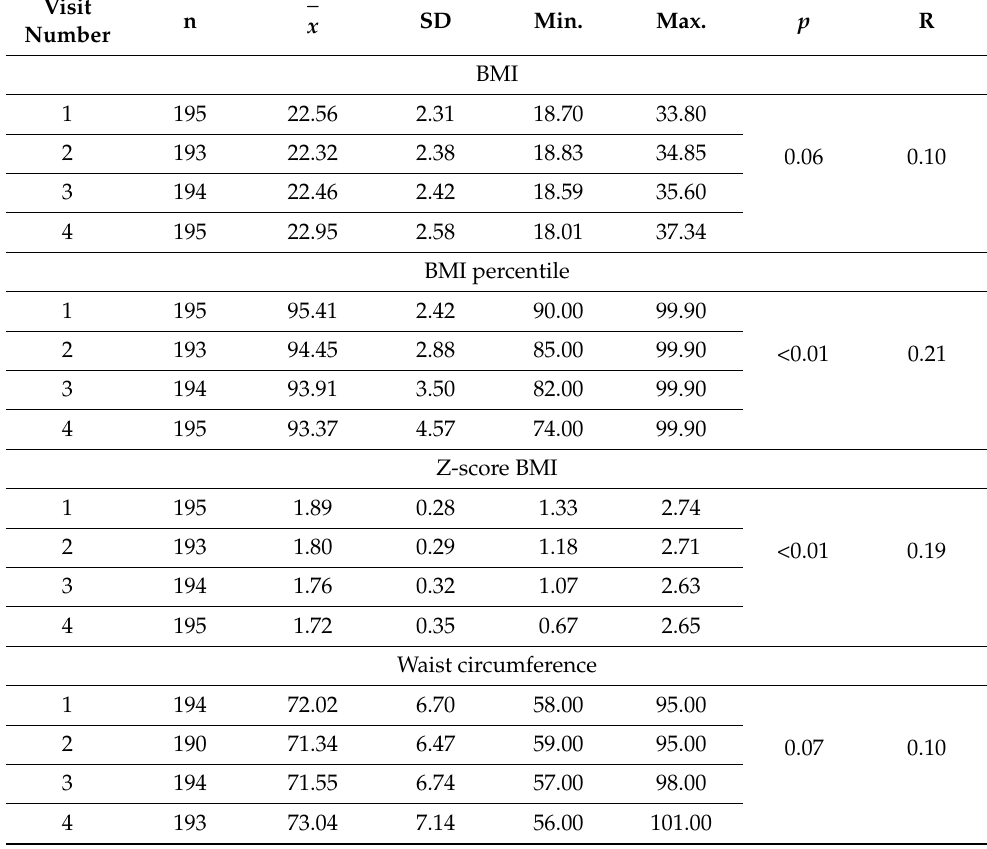
Table 7. Anthropometric parameters of children in group